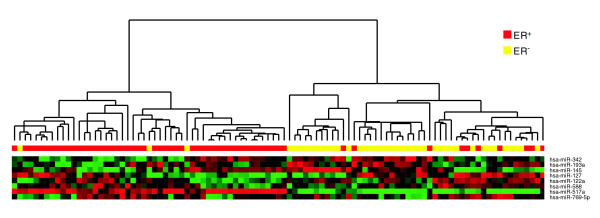
RE-score profiles of microRNAs for the classification of ER+ and ER- breast tumors. The figure demonstrates unsupervised hierarchical clustering of 57 ER+ and 42 ER- samples in the MN dataset [39] using the top 8 RE-changing miRNAs. A dendrogram of the tumors is shown at the top, with ER+ samples in red and ER- samples in yellow. For hierarchical clustering, RE-scores of each miRNA were mean centered and normalized, and tumors were clustered using Pearson correlation (uncentered) and average linkage (CLUSTER and TREEVIEW software) [73].